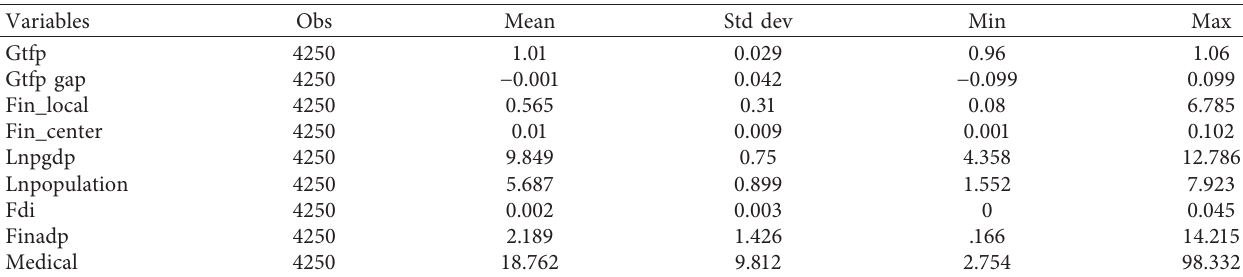
Table 2: Descriptive statistics.